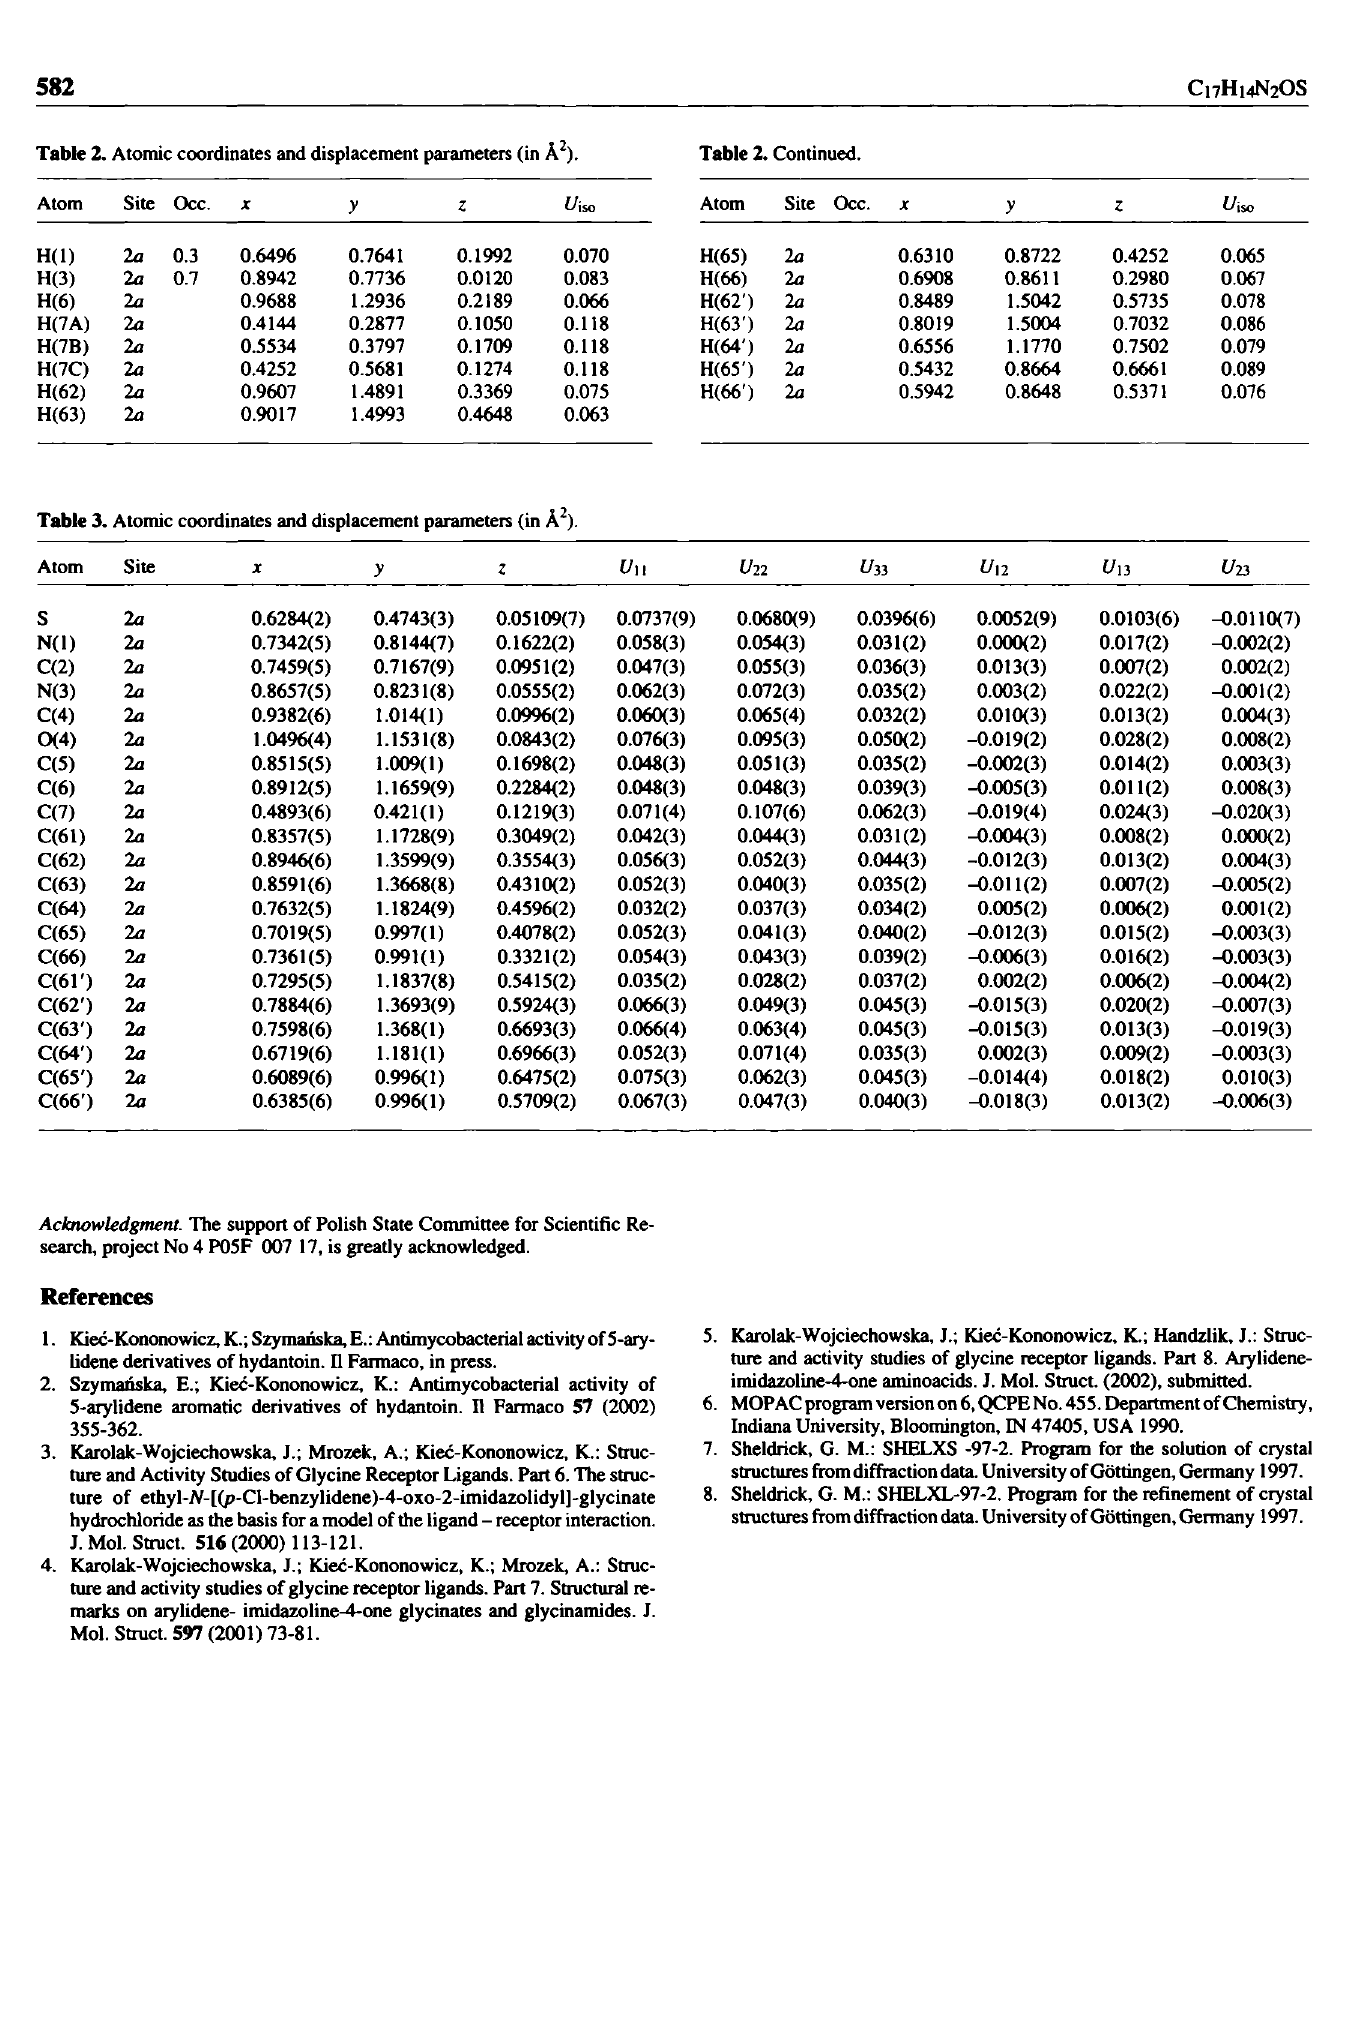
Table 3. Atomic coordinates and displacement parameters (in Â 2